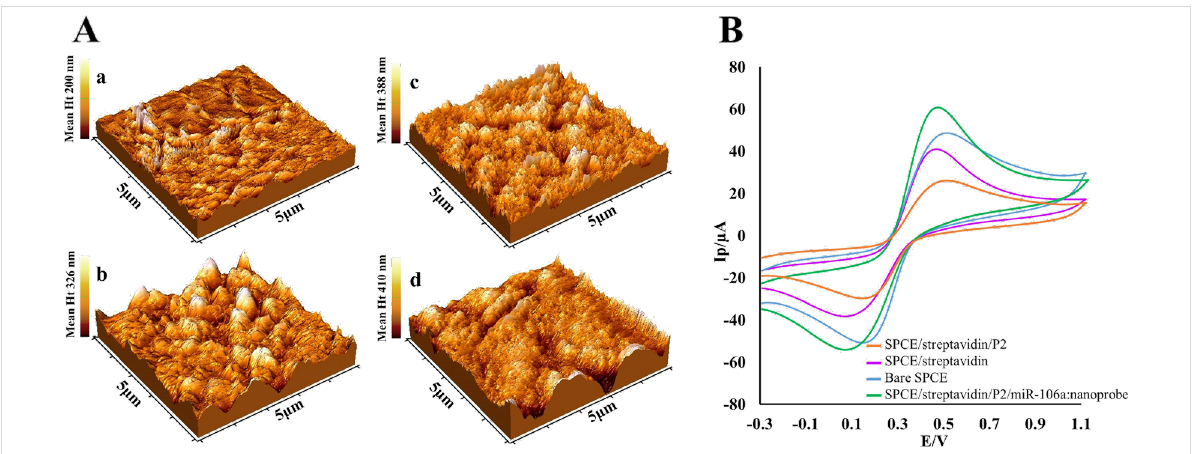
Figure 3: (A) AFM images of (a) a bare SPCE, (b) a SPCE after coating with streptavidin, (c) after immobilization of P2, and (d) after hybridization with the target complex. (B) Cyclic voltammograms carried out in 5.0 mM [Fe(CN) 6 ] 3 − /4 − solution containing 1.0 M KCl, at a scan rate of 100 mV/s for bare SPCE (blue), streptavidin-coated SPCE (purple), P2/streptavidin-coated SPCE (orange), and after hybridization with the target complex